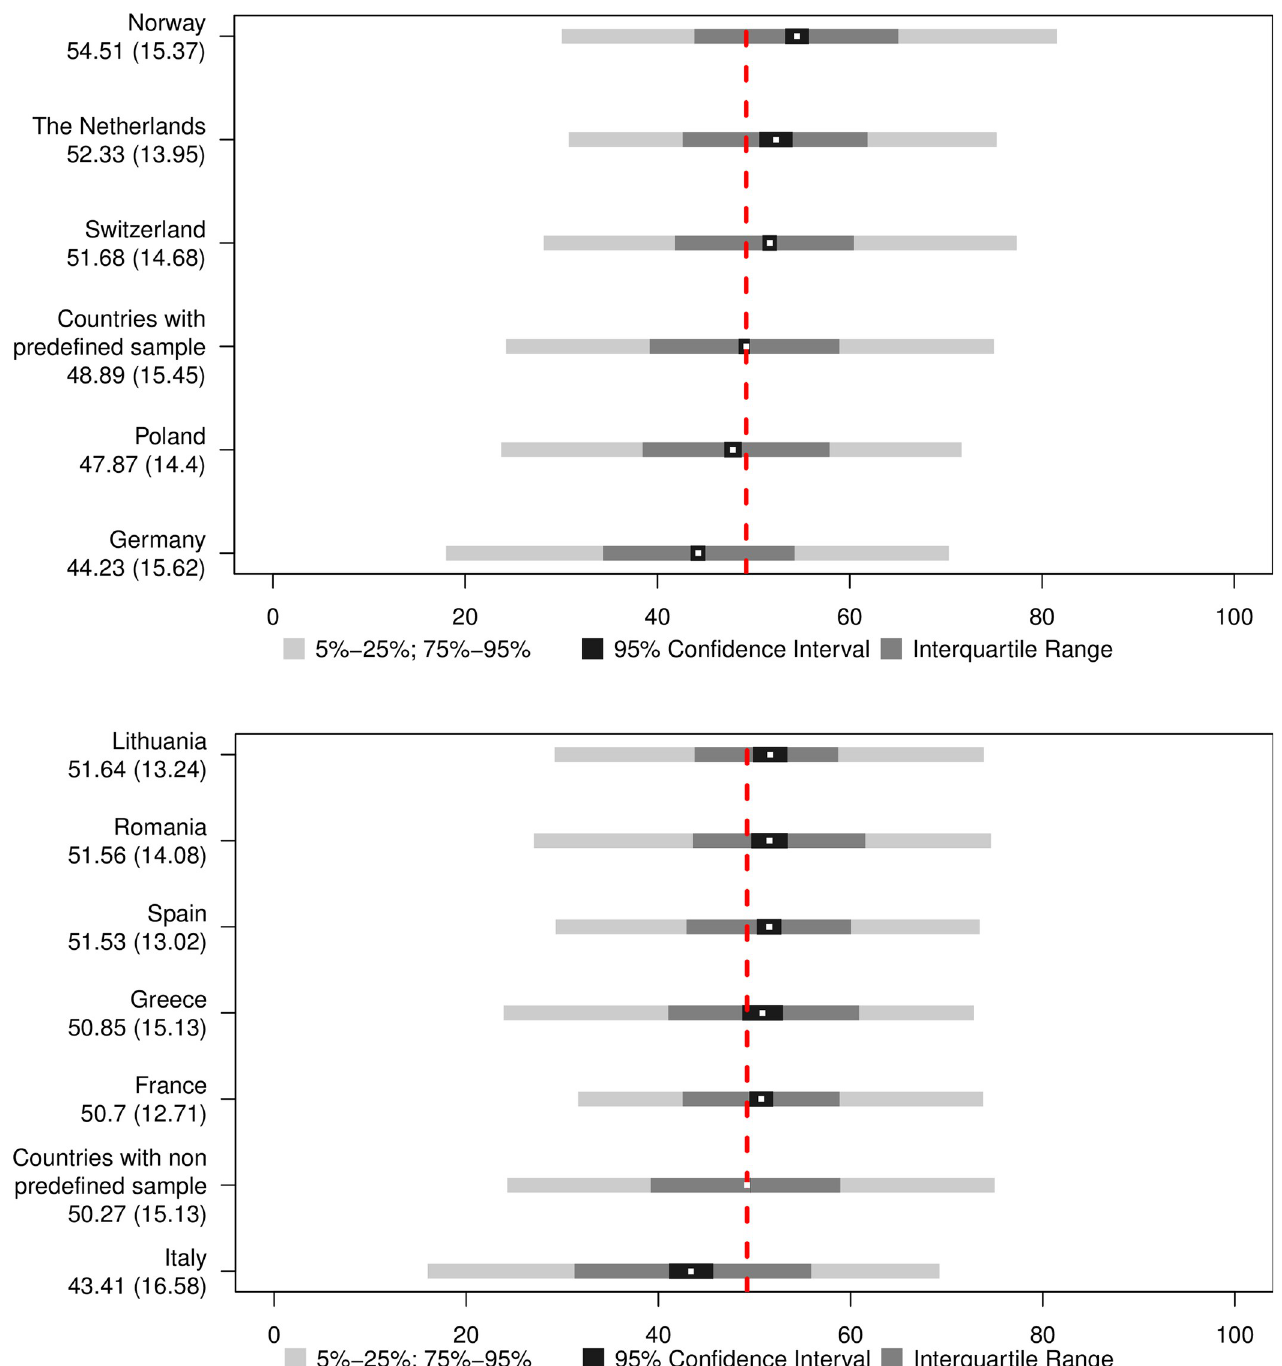
Fig 1. a. Distributions of overall functioning scores by country with a pre-defined sampling frame strategy and representative samples. The red dashed line cuts across the mean of the displayed countries. Mean and the standard deviation are displayed below the country name. The mean is also displayed in the graph by the white dots. b. Distributions of overall functioning scores by countries with convenience samples. The red dashed line cuts across the mean of the displayed countries Mean and the standard deviation are displayed below the country name. The mean is also displayed in the graph by the white dots.